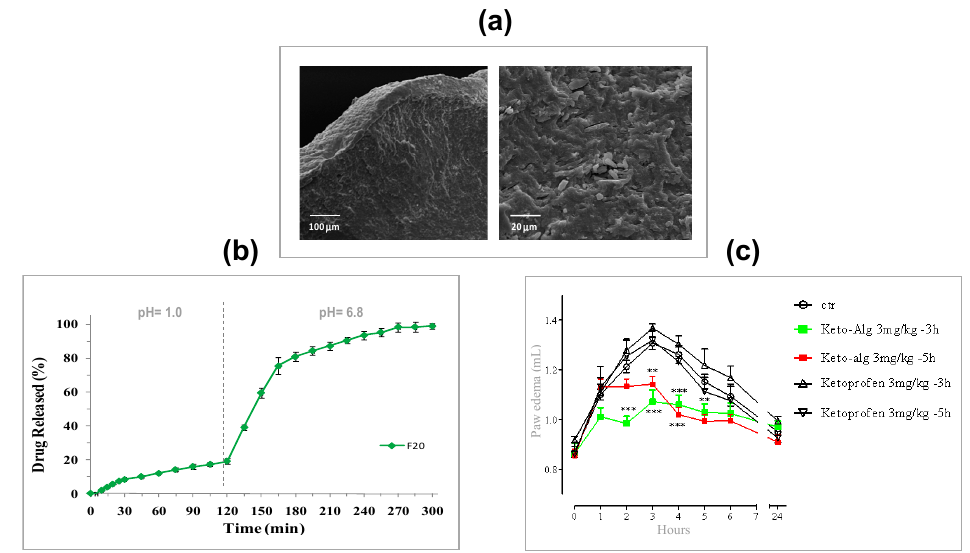
Figure 11. Main in vitro and in vivo results obtained for Zn-alginate-based xerogel beads loaded with ketoprofen: ( a ) SEM microphotographs showing the compact inner matrix; ( b ) relese profile performed by USP Apparatus 4 and, ( c ) edema volume reduction in rats (** p -value ≤ 0.01, *** p -value ≤ 0.001 compared with control). These images were here reprinted (with some modifications) from [202] with permission from Elsevier. Copyright